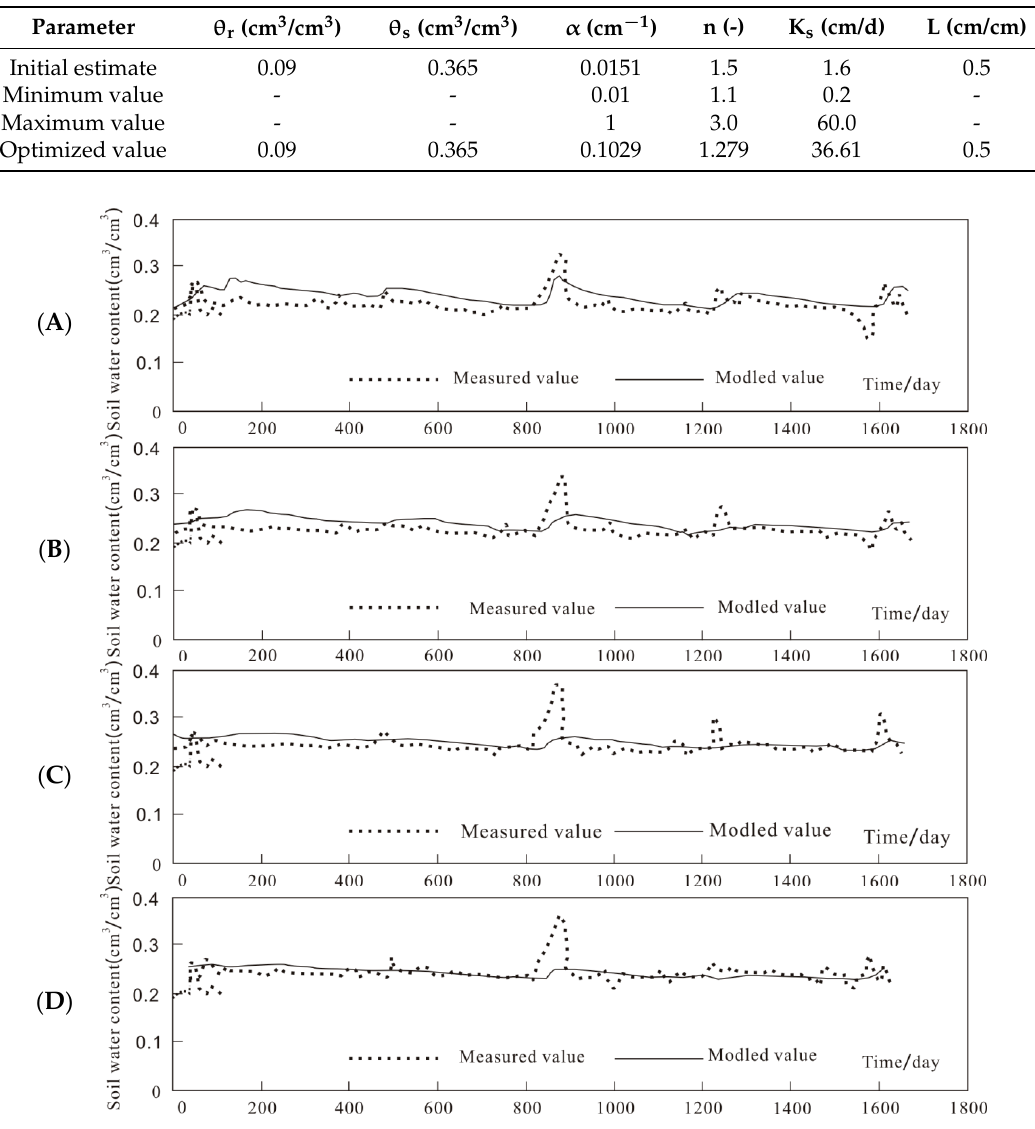
Table 4. Result of the hydraulic parameter estimation by the inverse method.